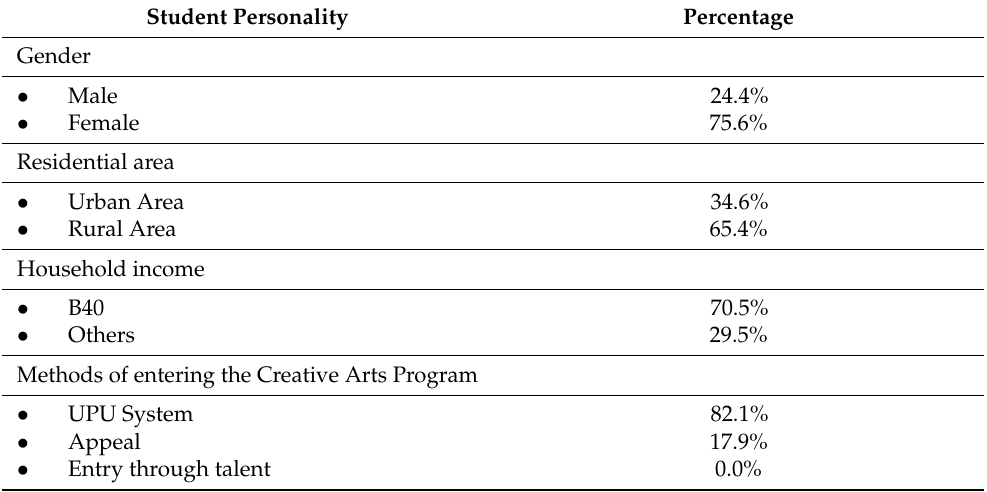
Table 2. Student Personality Information.